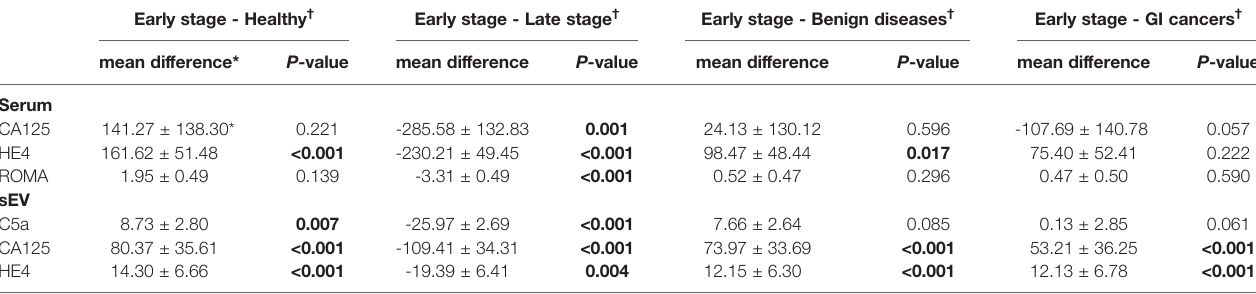
TABLE 4 | Comparison of protein levels from serum sEVs and serum in early-stage EOC patients versus healthy subjects, late-stage EOC, benign ovarian disease, and gastrointestinal cancer patients.